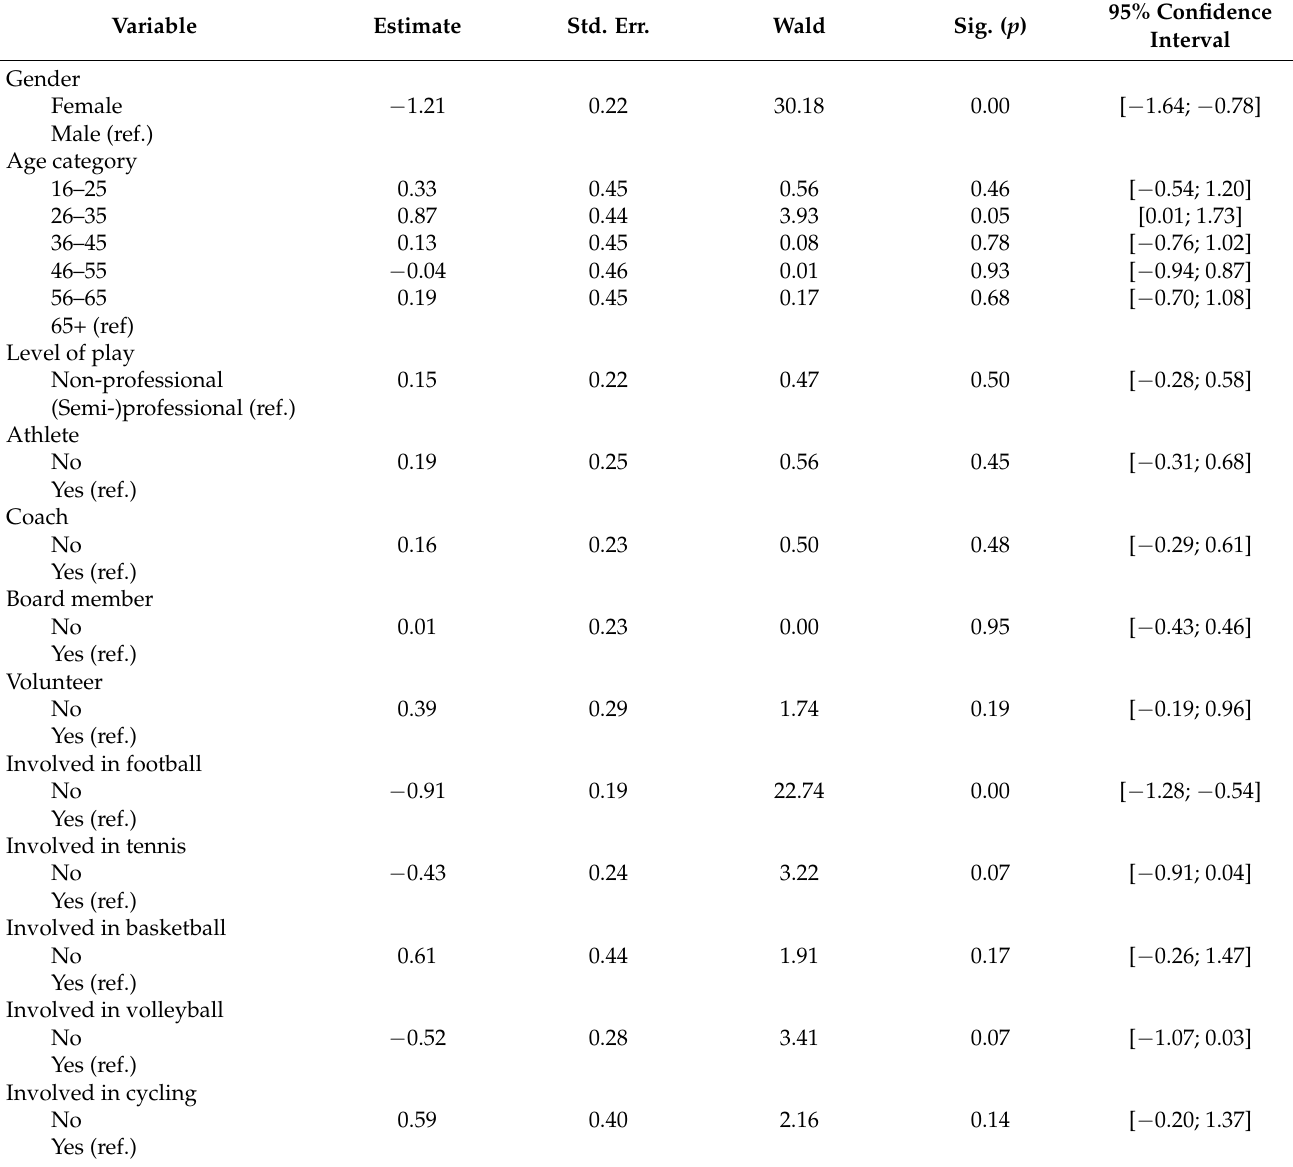
Table 3. Output ordinal logistic regression analysis of risk factors for problem gambling in sport ( n =